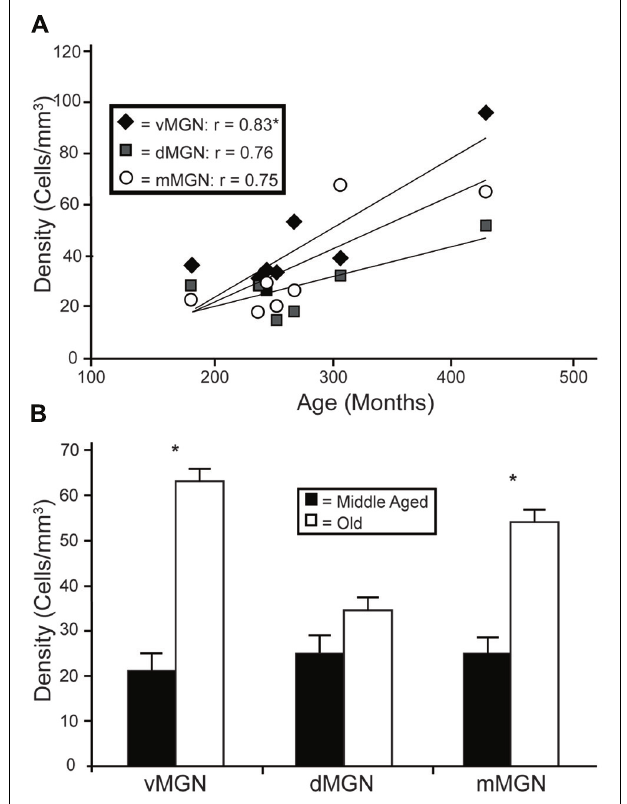
FIGURE 3 |Age-related changes in PV positive neuron density from the three subdivisions of the MGN. (A) Regression analyses of the estimated cell densities from the ventral MGN (vMGN; black diamonds), dorsal MGN (dMGN; gray squares), and magnocellular MGN (mMGN; white circles) as a function of age showed a significant correlation only in the vMGN. (B) Estimated cell densities of the vMGN, dMGN, and mMGN when the animals were combined into middle aged and old age groups revealed significant increases in both the vMGN and mMGN. Asterisks indicate significance by an unpaired t -test at an alpha level of